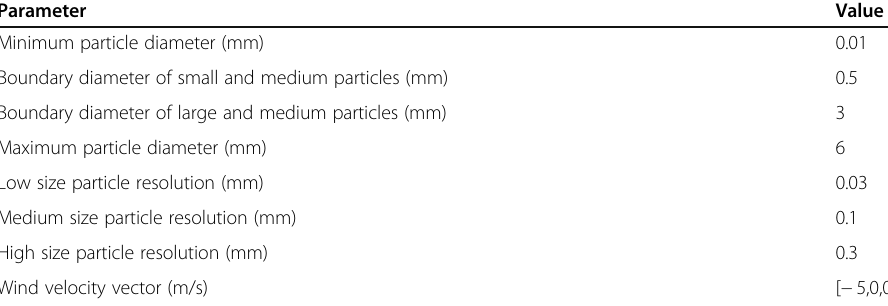
High size particle resolution (mm) Wind velocity vector